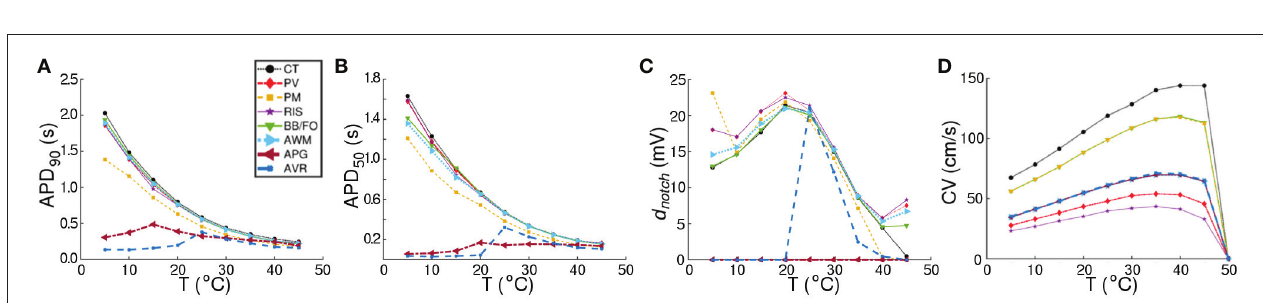
FIGURE 4 | Comparison of region-specific temperature-dependencies of AP characteristics (A) APD 90 , (B) APD 50 , and (C) notch depth ( d notch ), and (D) conduction velocity (CV) under normal (Control)